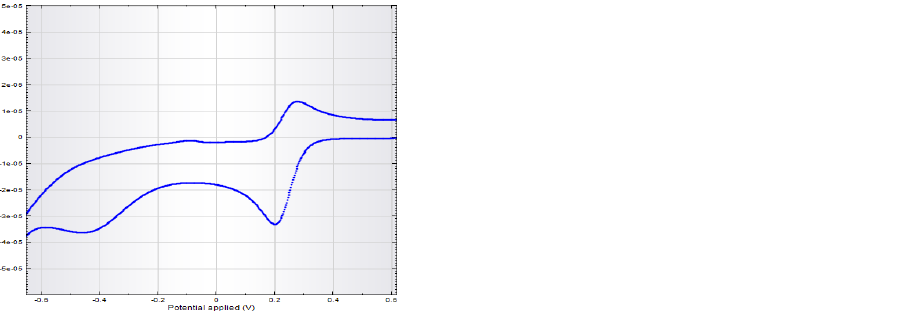
shift to higher oxidation potentials and its decrease, this behavior being similar to that observed in the case of ascorbic acid, the control antioxidant.